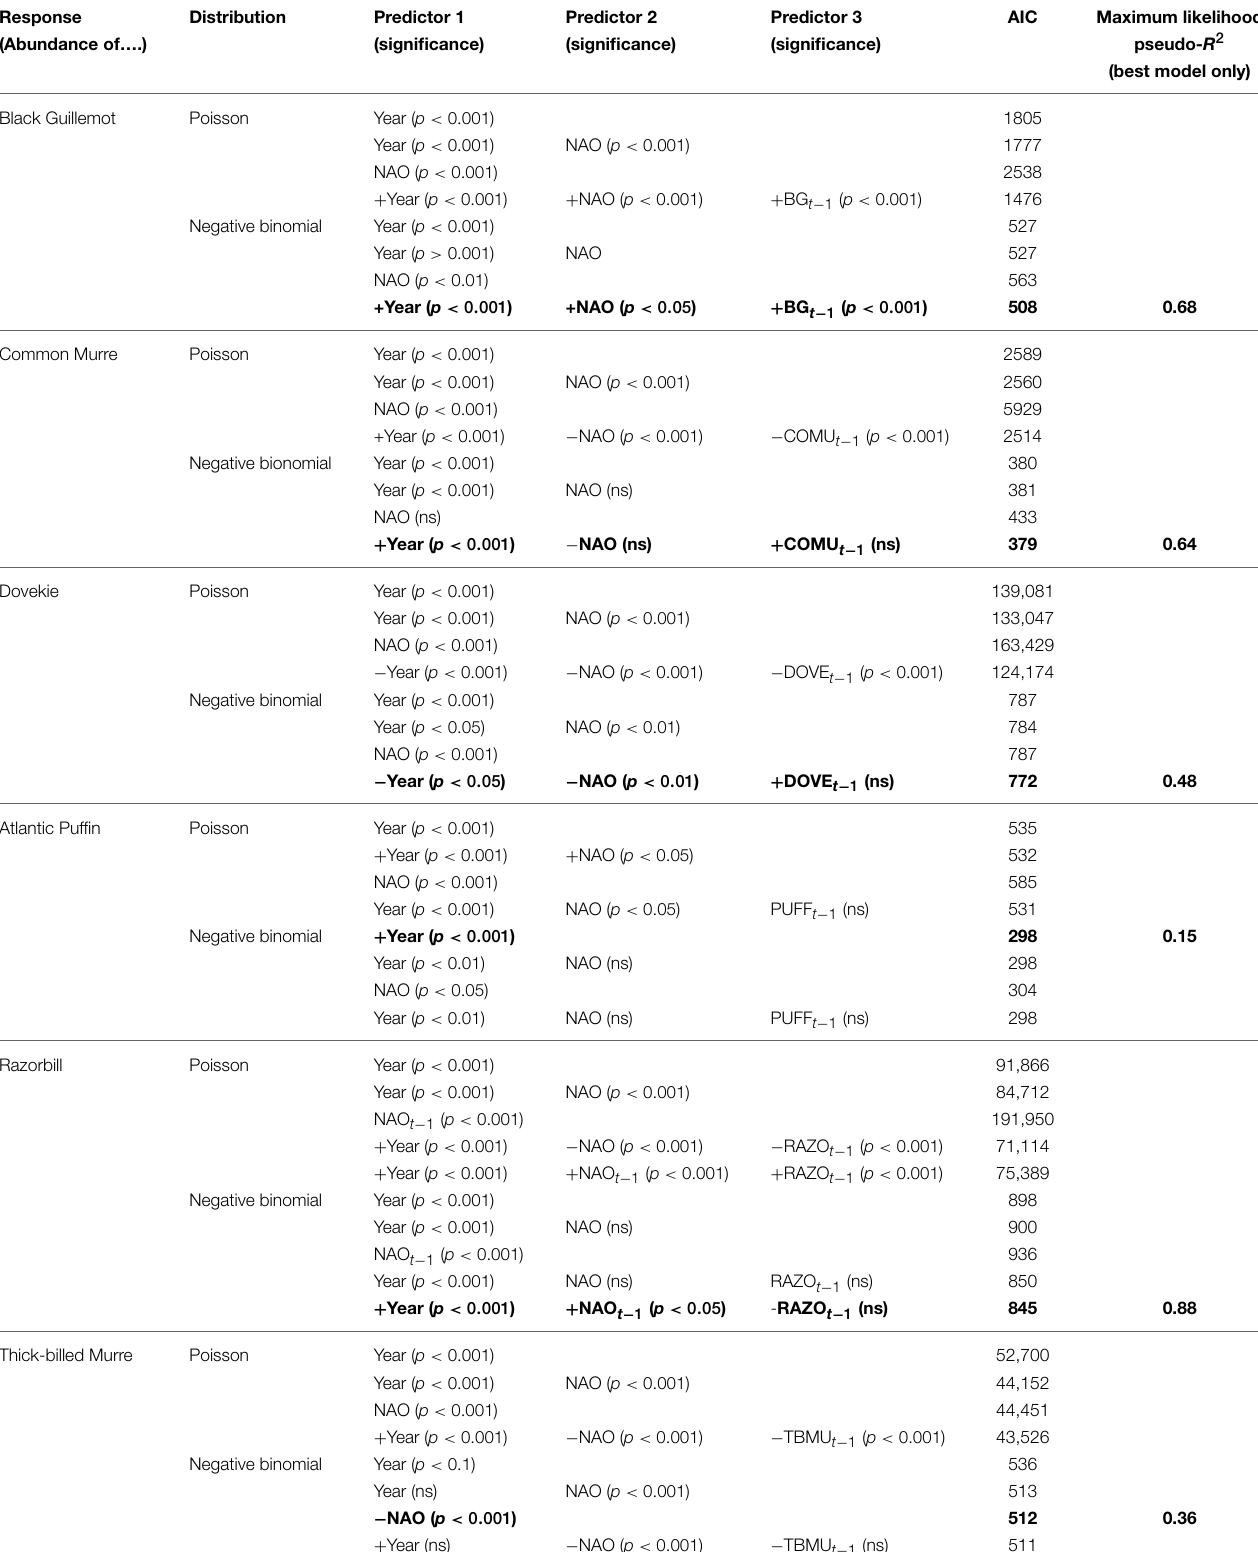
TABLE 1 | Results of model selection for six alcid species wintering population numbers; sign of relationship with predictors given in best model. Response (Abundance